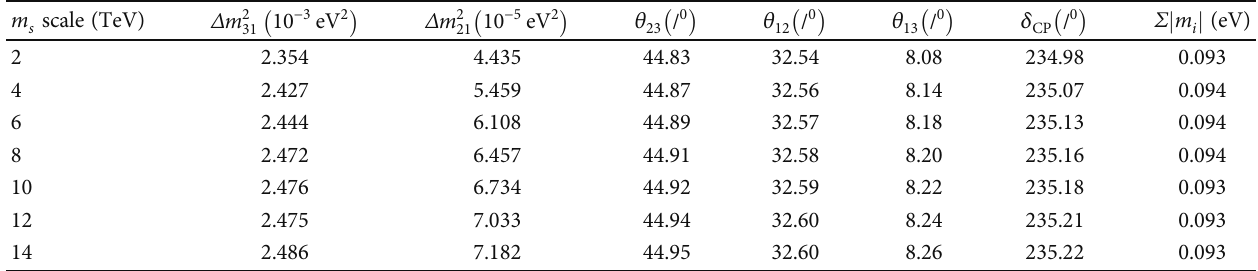
for NH case ( tan β = 40 , M s